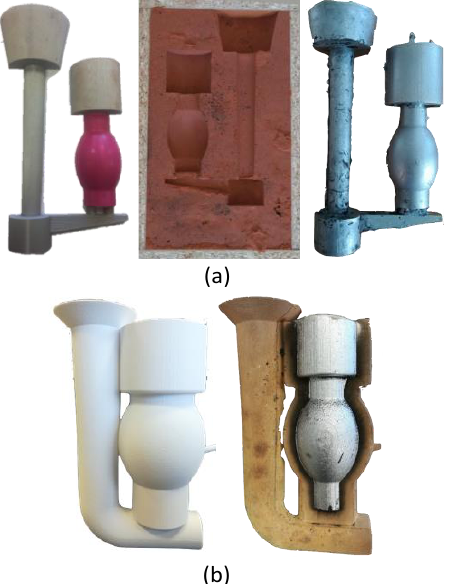
Figure 10. ( a ) Stages of the sand casting manufacturing process, ( b ) stages of the 3DP manufacturing process.